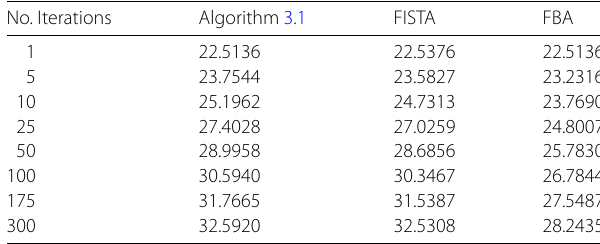
Table 3 The values of PSNR at x 1 , x 5 , x 10 , x 25 , x 50 , x 100 , x 175 , x 300 (Wat Boonyawad) No. Iterations Algorithm 3.1 FISTA FBA